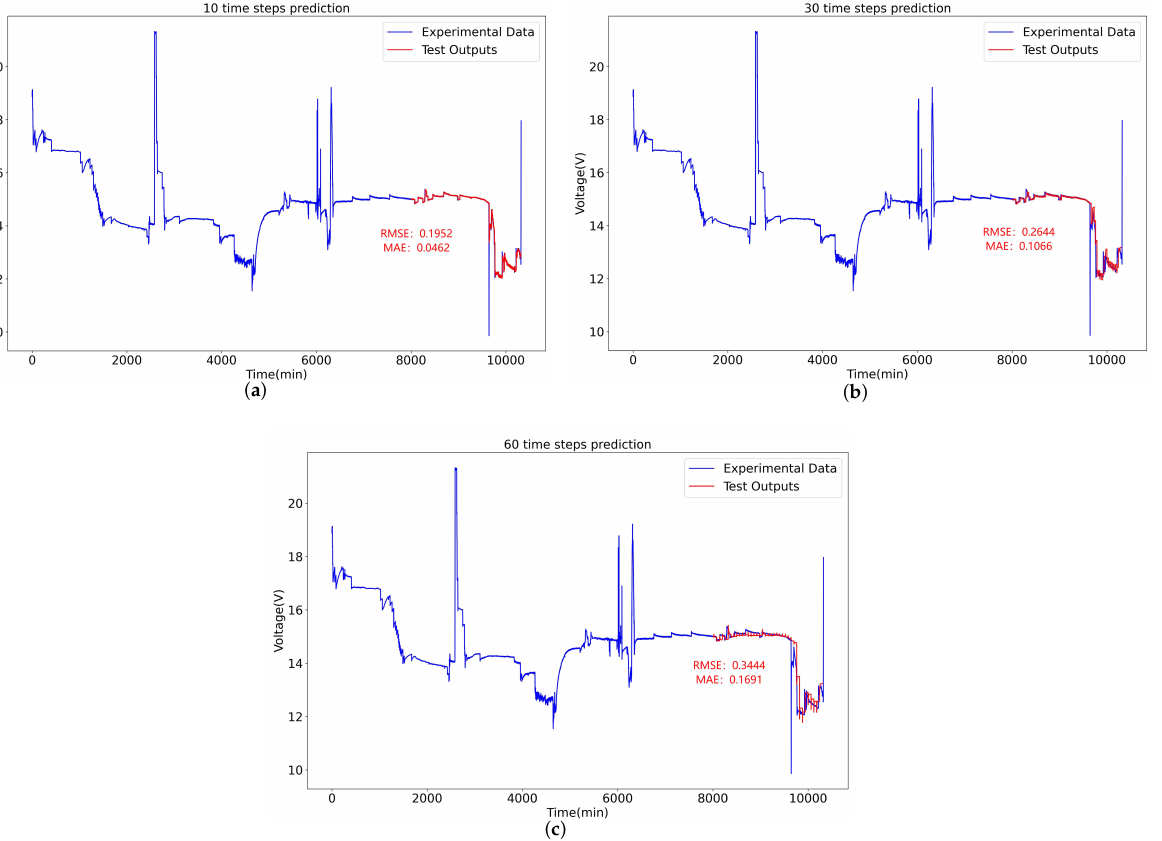
Figure 9. Multi-step LSTM prediction model prediction curves for SOFC systems output voltage at different output time steps. ( a ) Prediction curve for 10 time steps. ( b ) Prediction curve for 30 time steps. ( c ) Prediction curve for 60 time